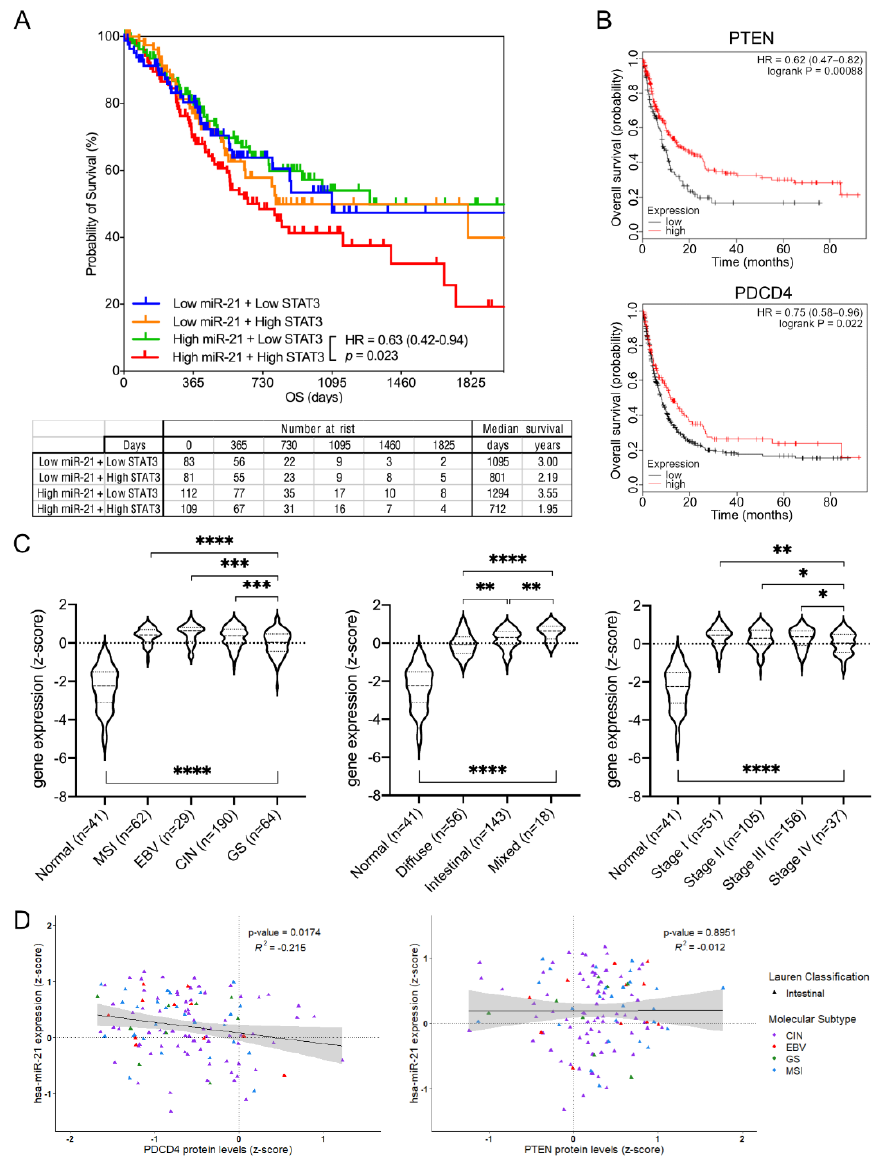
Figure 8. Transcriptomic and proteomic expression analyses across the Stat3-miR-21 signaling cascade in human GC. ( A ) Overall survival analysis of gastric cancer patient cohorts separated into the low and high expression of miR-21 and STAT3, respectively. ( B ) Overall survival analysis of gastric cancer patient cohorts separated at the mean expression into the low and high expression of the mir- 21 target genes PTEN or PDCD4. ( C ) mir-21 transcript levels in the TCGA-STAD dataset grouped